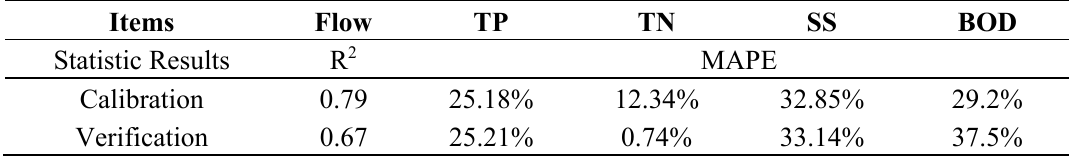
Table 1. Statistical results of model calibration and